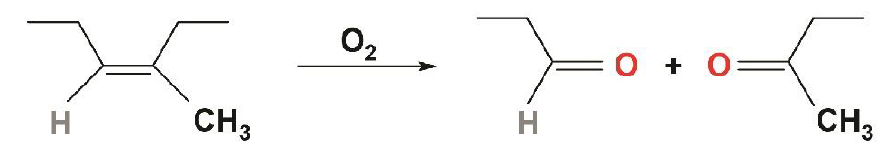
Figure 14. A representation of oxidative softening-chain scission [33].